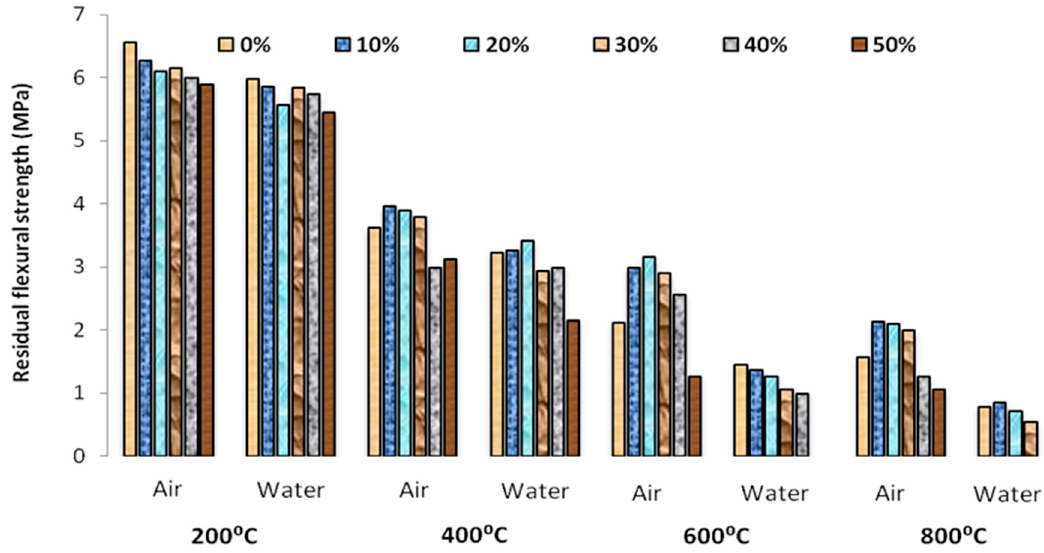
Figure 13. Residual flexural strength of SCGM at high temperature subjected to air and water cooling.